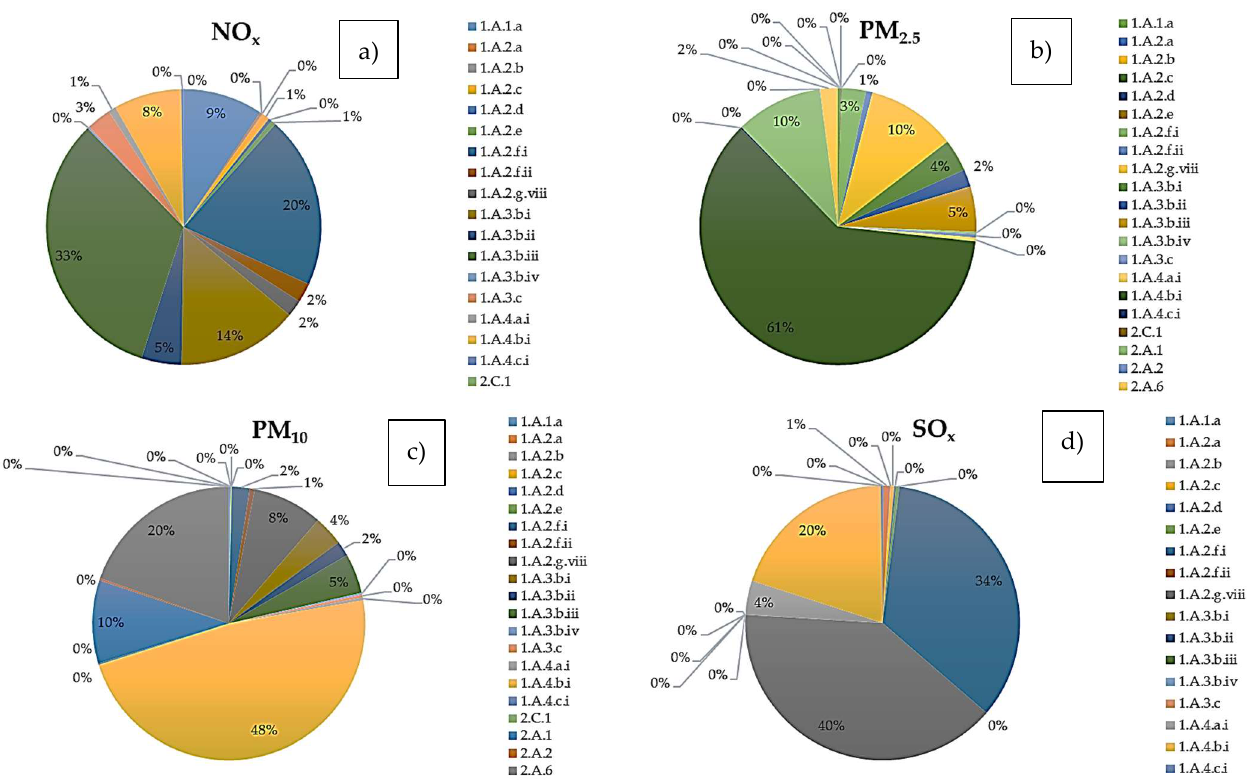
Figure 2. Distribution of principal pollutant emitting. ( a ) NOx; ( b ) PM 2.5 ; ( c ) PM 10 ; ( d ) SOx; in respect